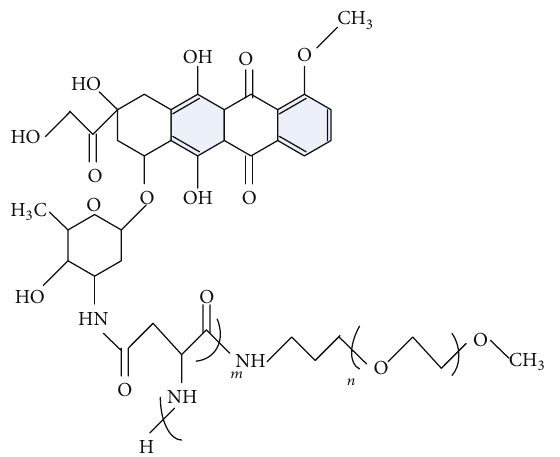
Figure 1: Dox-loaded micelle comprising PEG-PAsp block copoly- mer with chemically conjugated Dox 𝑆𝑃[𝑛] .